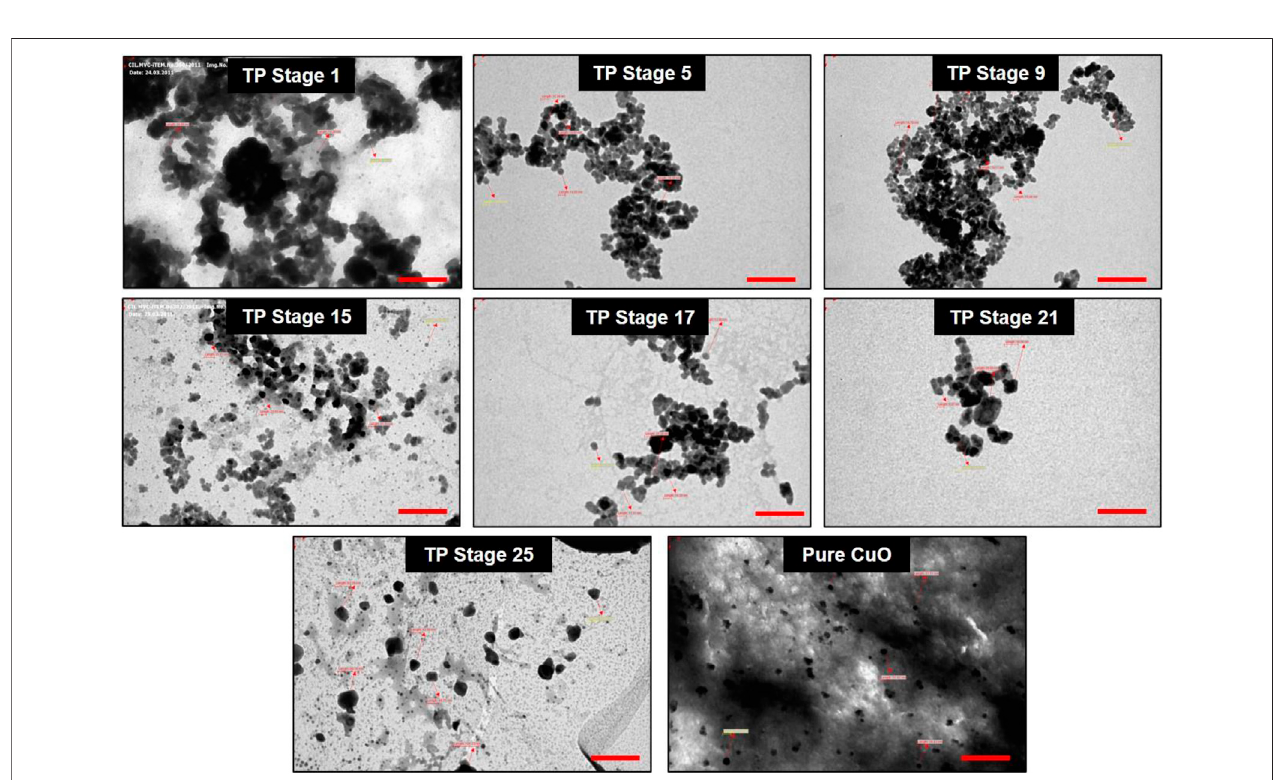
FIGURE 8 | Transmission electron microscopic (TEM) photograph of Thamira parpam particles obtained at various stages of preparation using the traditional ancient method. Scale bar indicates 200 nm.